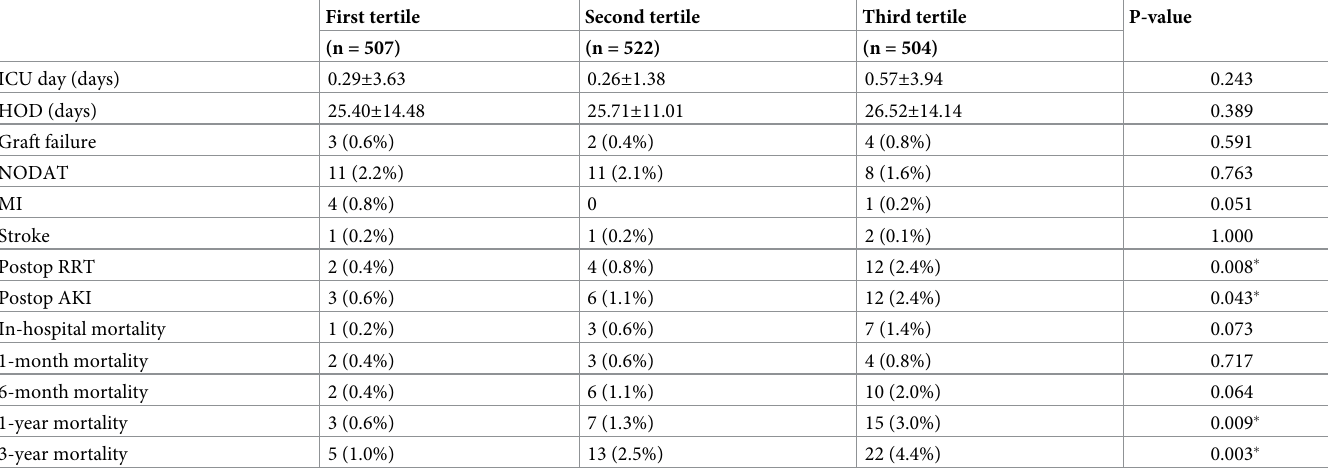
Table 2. Postoperative morbidity and mortality of patients.